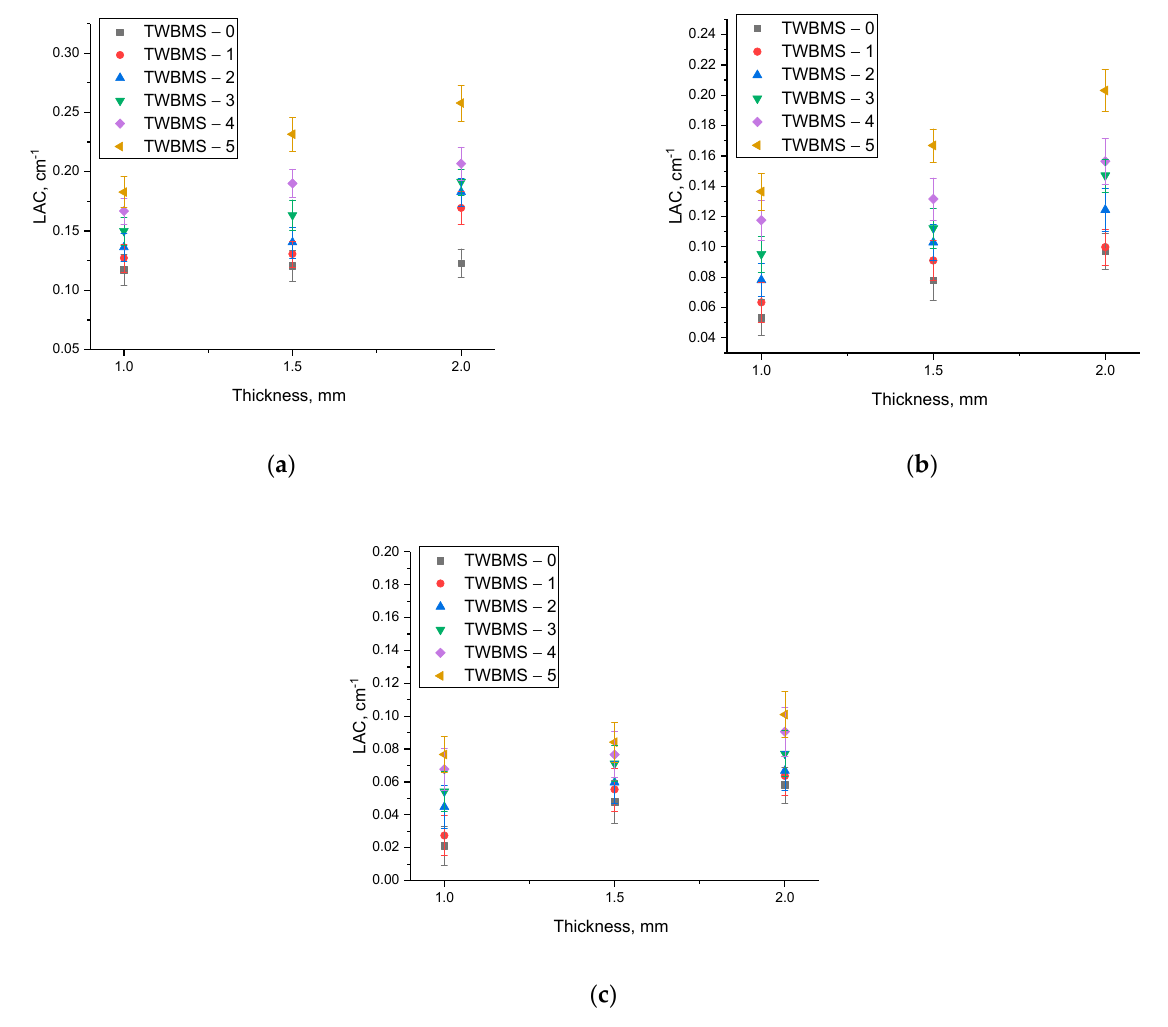
Figure 6. Changes in the LAC value depending on the thickness of the glasses:( a ) Co 57 , 130 keV; ( b ) Cs 137 , 660 keV; ( c ) Na 22 , 1270 keV. ( b ) Cs 137 , 660 keV; ( c ) Na 22 , 1270